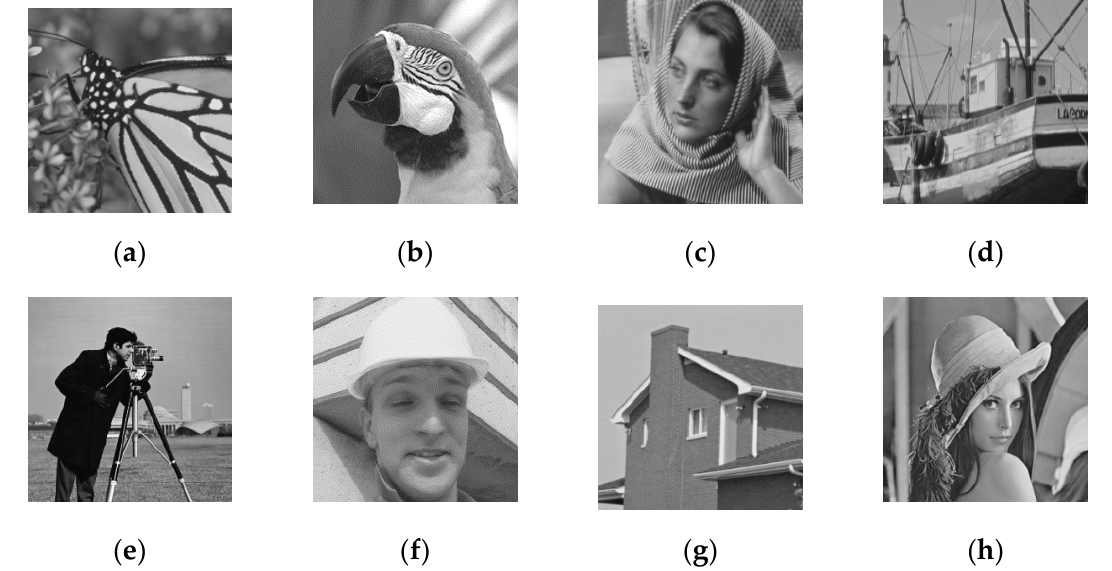
Figure 11. Eight test images: ( a ) Monarch; ( b ) Parrot; ( c ) Barbara; ( d ) Boats; ( e ) Cameraman; ( f ) Fore- man; ( g ) House; ( h ) Lena.